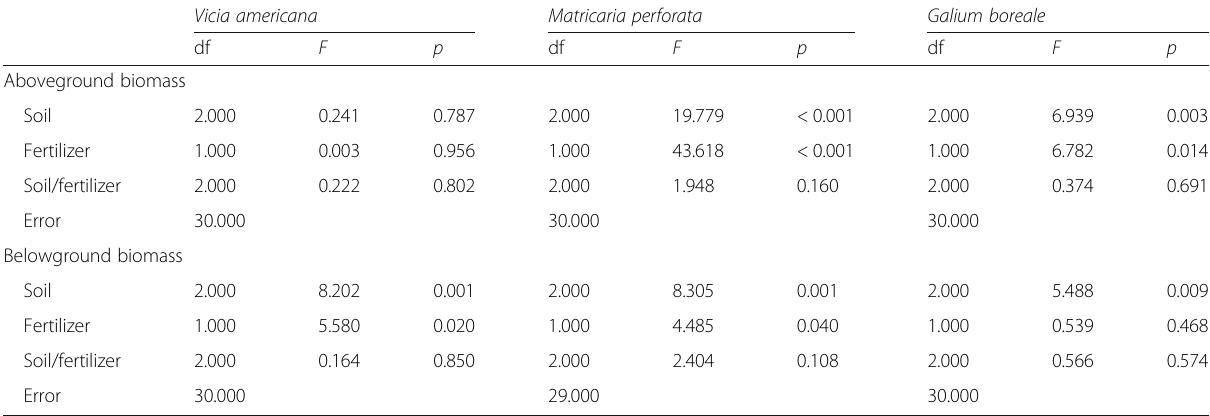
Table 2 ANOVA table of F and p values on the effects of soil and fertilizer on above- and belowground biomass for different species. Species were subset before the ANOVA was performed Vicia americana Matricaria perforata